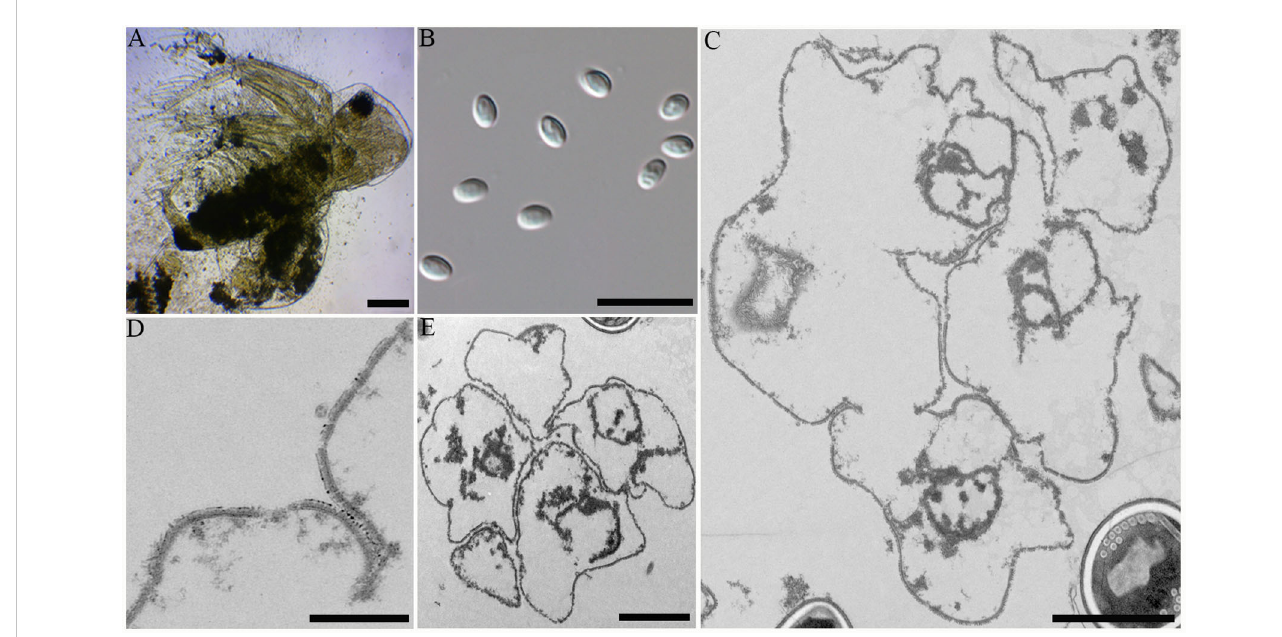
FIGURE 2 Microscopic observation of Neo fl abelliforma dubium n. sp. (A) Infected Diaphanosoma dubium appears opaque, scale bar = 100 m m. (B) Fresh spores liberated from infected D dubium , scale bar = 10 m m. (C) Multinucleate sporogonial plasmodia developed into sporoblasts by rosette-like budding, scale bar = 2 m m. (D) The magni fi cation of the electron-dense tubular projections on the cell plasma membrane, scale bar = 1 m m. (E) Five irregular sporoblasts were direct contact with the host cell cytoplasm, scale bar = 100 m